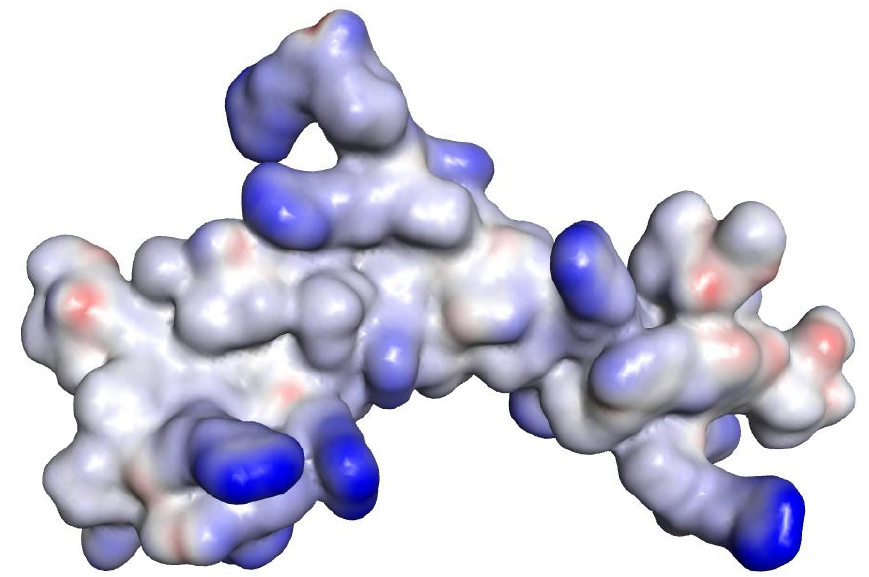
Figure 2. MEP of the representative complex formed by compound 27 (peptide sequence RPRRPRLPW-NH 2 ) and novobiocin molecules. Positive values are shown in blue, hydrophobic regions in grey and negative values in red.